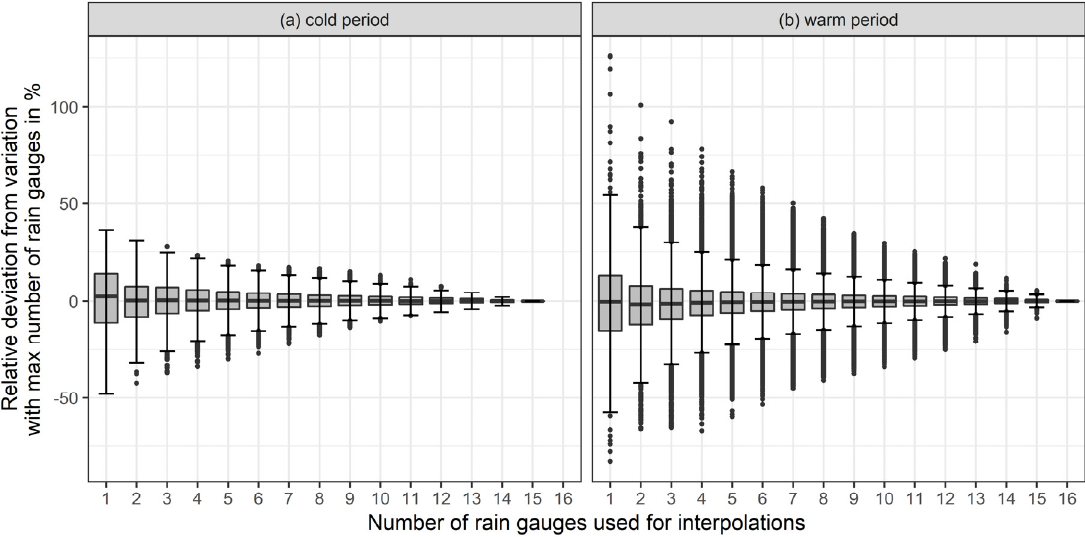
Figure 3. Relative deviations of the mean rainfalls (calculated from spatial interpolations of rainfall events) from the mean rainfall calculated from the spatial interpolation with the highest rain gauge density (all available rain gauges used as sample size). The mean rainfalls are shown as boxplots grouped by the used sample size for the spatial interpolation of the event rainfall: ( a ) cold period = fall and winter and ( b ) warm period = spring and summer.